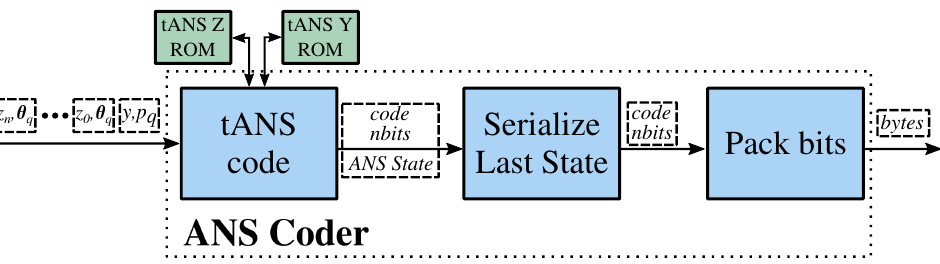
Figure 8. ANS coder block diagram showing the transformation of sub-symbols into packed